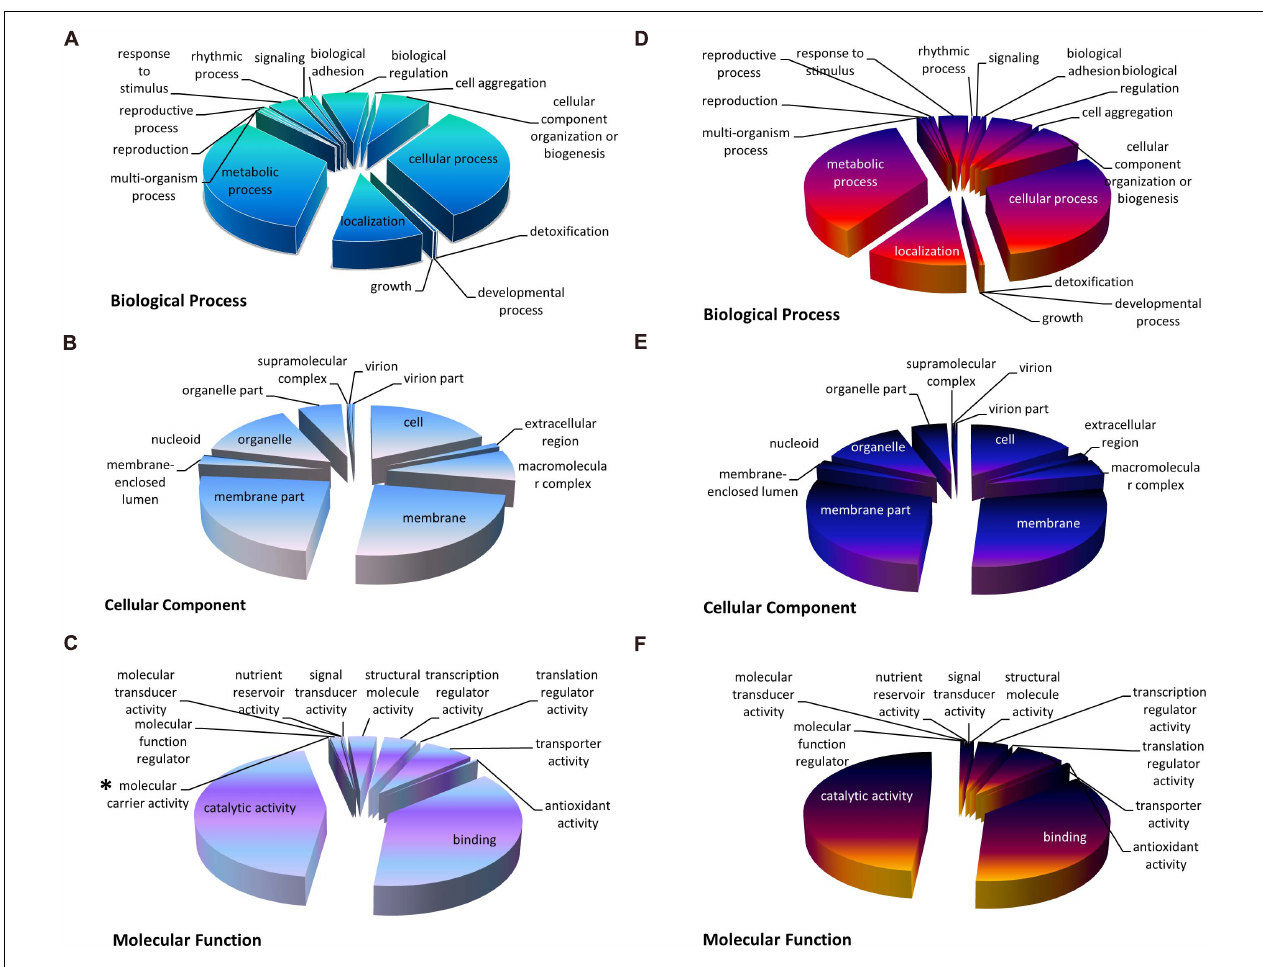
FIGURE 3 | The Gene Ontology (GO) classification of DEGs under different nitrogen treatments in Verticillium dahliae . GO classification of identified DEGs based on their functional annotations in response to various nitrogen sources was conducted according to the GO resource (http://geneontology.org/). The treatments included 10 mM nitrate (NO 3 − ) or 10 mM ammonium (NH 4 + ) amendments, or control. (A–C) Indicates biological processes, cellular components, and molecular function under nitrate treatment, while (D–F) indicate biological processes, cellular components, and molecular function under ammonium treatment, respectively. *Indicates that the term appeared only once.